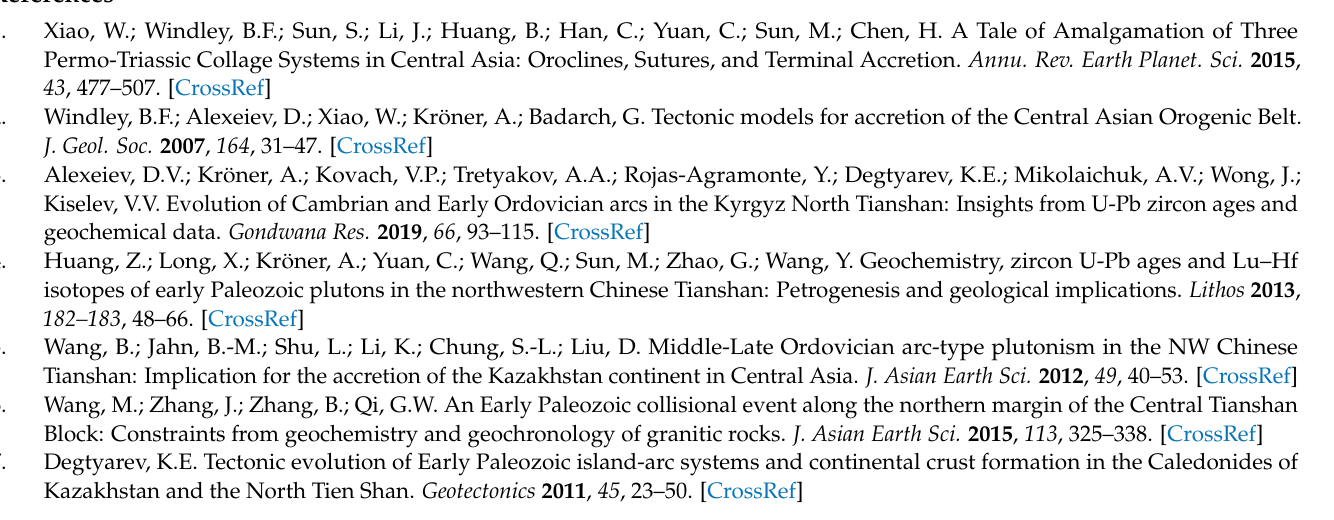
Haerdaban area. Table S2: Zircon Lu–Hf isotopic data for the volcanic rocks in the Haerdaban area, northern margin of Yili Block. Table S3: Major and trace element data for the volcanic rocks in the Haerdaban area, northern margin of Yili Block. Table S4: Whole-Rock Sr–Nd isotopic compositions of the volcanic rocks in the Haerdaban area, northern margin of Yili